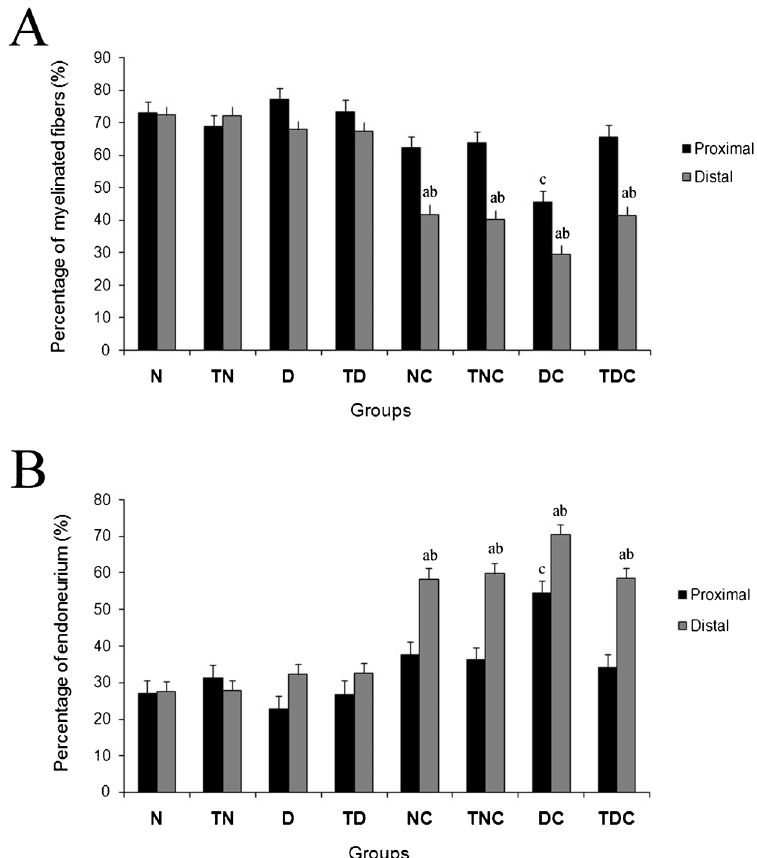
Figure 4 - Graphs showing the morphometrical parameters in the proximal and distal portions of the sciatic nerve in non-diabetic (N, n=6), trained non-diabetic (TN, n=6), diabetic (D, n=6), trained diabetic (TD, n=8), non-diabetic submitted to sciatic nerve crush (NC, n=6), trained non-diabetic submitted to sciatic nerve crush (TNC, n=6), diabetic submitted to sciatic nerve crush (DC, n=9) and trained diabetic submitted to sciatic nerve crush (TDC, n=7) groups. A: Percentage of endoneurium and B: percentage of myelinated fibers. Data are expressed as means ¡ SEM. a P , 0.05 vs proximal portion in the same group; b P , 0.05 vs. distal portion in the N, TN, D, TD groups; c P , 0.05 vs. proximal portion in the N, TN, D, TD, NC, TNC and